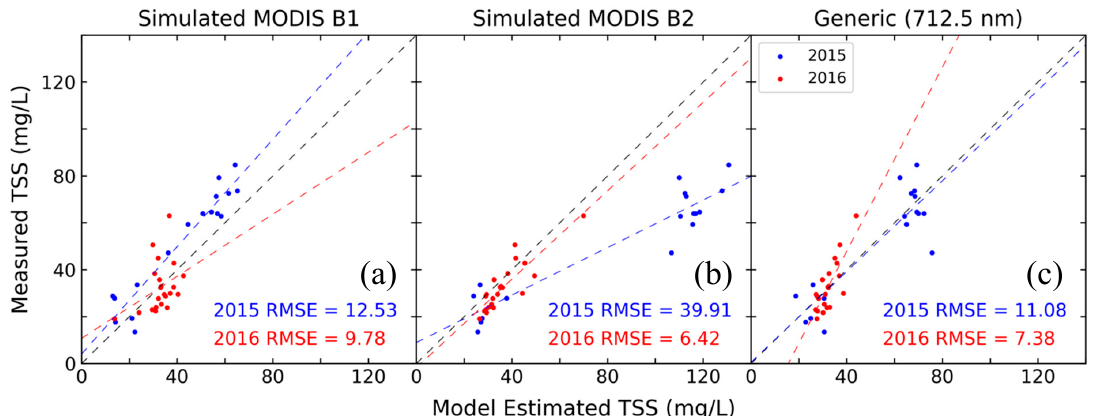
Figure 3. Validation scatterplots for the simulated MODIS OLSR and generalized (712.5 nm) [18] models based on the 2015 and 2016 Atchafalaya and Wax Lake Delta datasets. The ( a ) Band 1 and ( b )